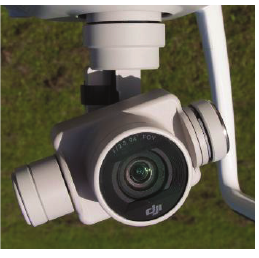
Figure 1: UAV-based close-range photogrammetry – DJI Phantom 4 System